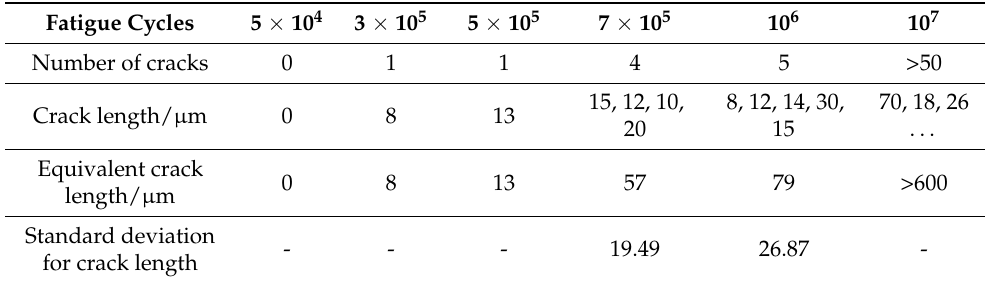
Table 4. Statistics of micro-cracks in the KMN-I vibration fatigue